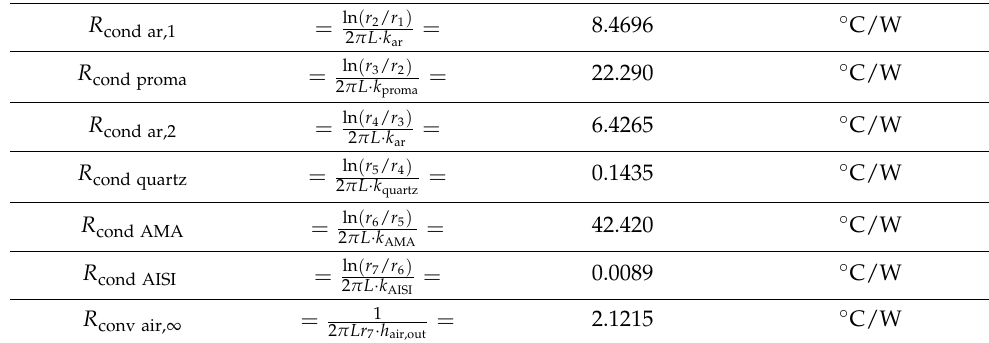
Table 2. Main thermal resistances corresponding to the coaxial material layers and to the gas filled cavities outside the heating element. Only the contributions of conduction and convection heat transfer were shown, specified by the subscripts cond and conv, respectively; ar and air denote argon and